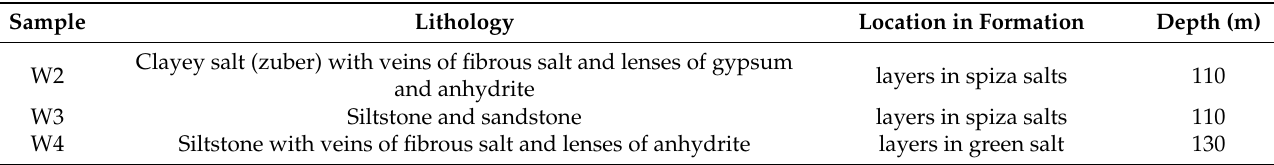
Figure 1. Location of Miocene evaporite deposits in the Carpathian Foredeep (adapted from Babel [27]). Table 1. List of samples, depths and lithological types.